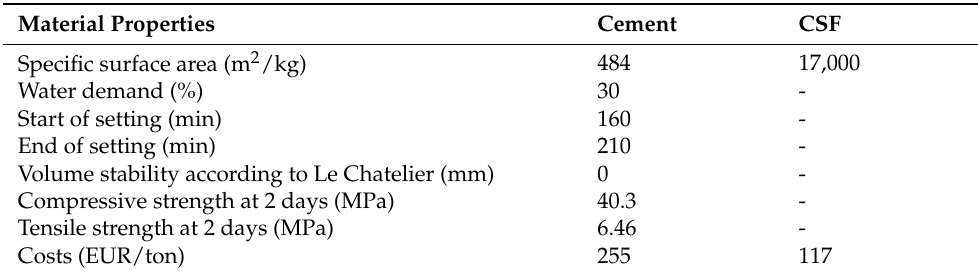
Table 1. Physical properties and costs of cement and CSF.